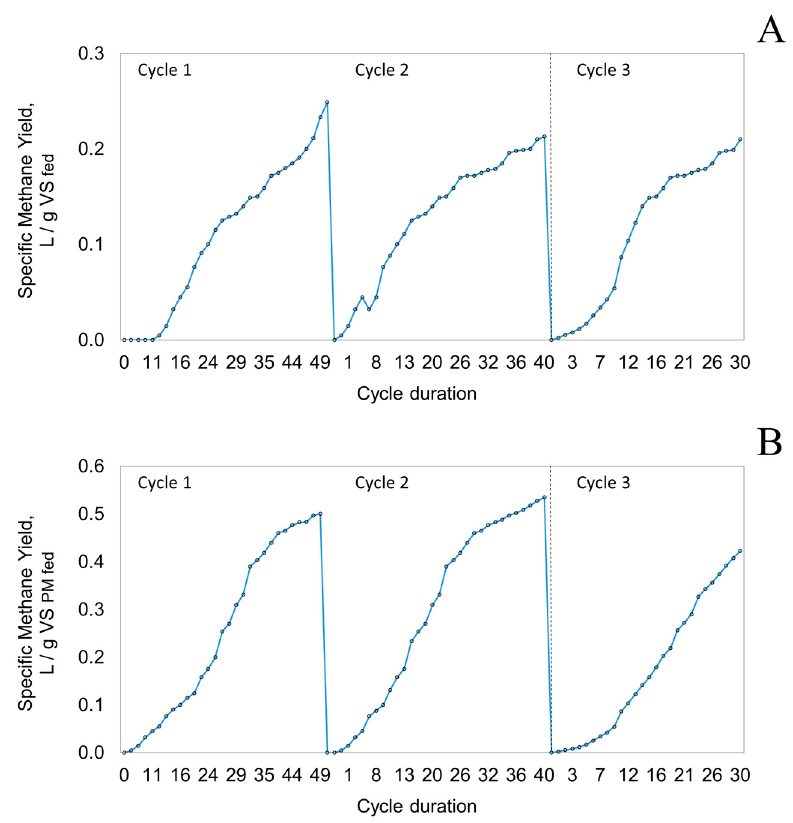
Figure 4. Specific methane yield profile for the percolation–recirculation mode of operation based on ( A ) volatile solids in feedstock and ( B ) volatile solids in pig-manure solids. ( A ) volatile solids in feedstock and ( B ) volatile solids in pig-manure